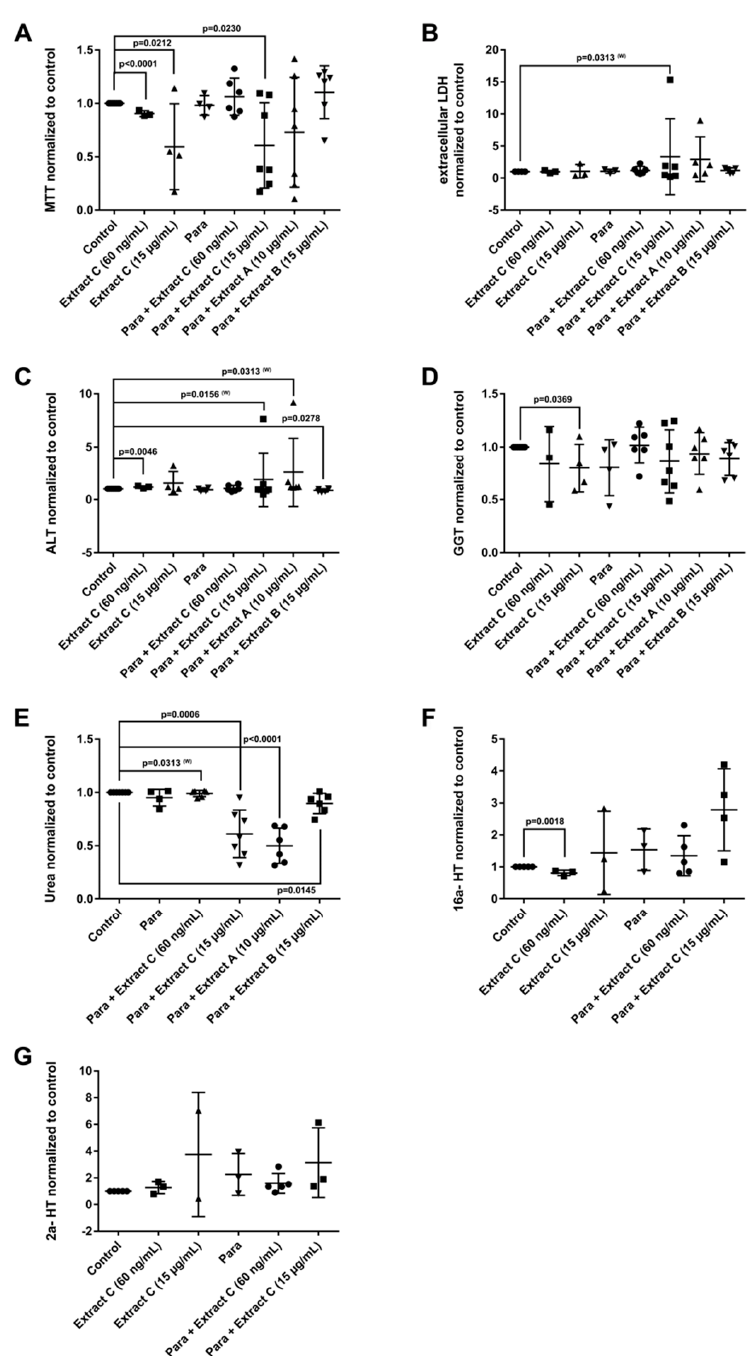
Figure 3. E ff ects of di ff erent Petasites hybridus extracts and Paracetamol on clinical liver function tests in cultures of human hepatocytes after daily treatment for 72 h. ( A ) MTT mitochondrial reductase activity. ( B ) LDH leakage / extracellular activity. ( C ) Alanine aminotransferase activity. ( D ) glutamyltransferase activity. ( E ) Urea production. ( F , G ) Testosterone 16 and 2 hydroxylation activity. The data of individual donors are given normalised to the DMSO vehicle control. The Petasites hybridus extracts A, B and C are specified to 37%, < 1% and 19.1% petasin, respectively. Extract C is the marketed product Petadolex ® and human hepatocyte cultures were treated at therapeutic C max ( = 60 ng / mL) and > 49-fold therapeutic petasin C max ( = 15 µ g / mL) concentrations. Hepatocyte cultures were also treated with Paracetamol at therapeutic C max ( = Para; 20 µ g / mL) concentrations and in combinations with di ff erent Petasites hybridus extracts. The data were analysed with the GraphPad Prism software version 6.05.